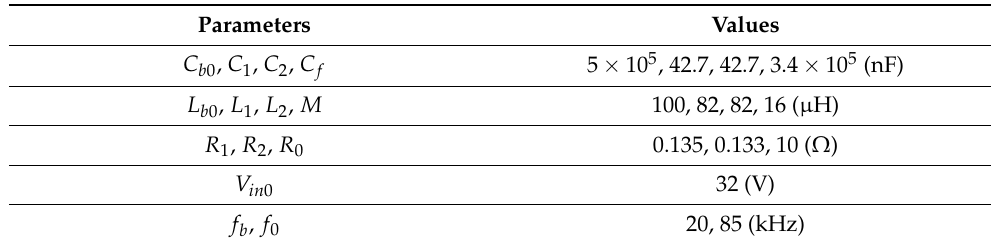
Table 1. Nominal parameter values of WPT-buck system.